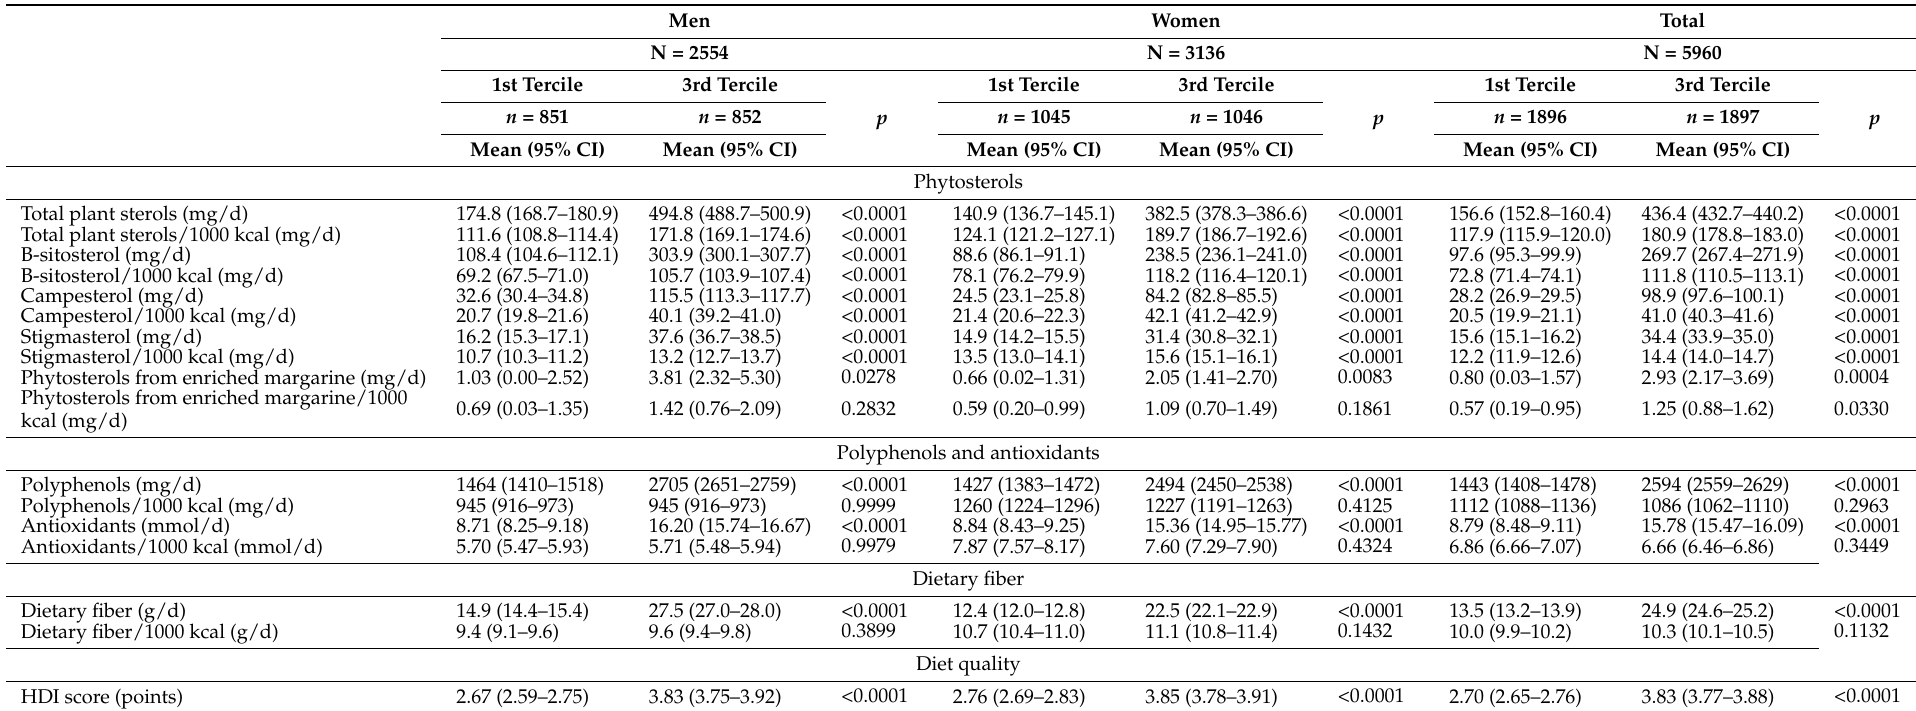
Table 4. Dietary quality in relation to tercile of dietary total and individual phytosterol intake (1st tercile vs. 3rd